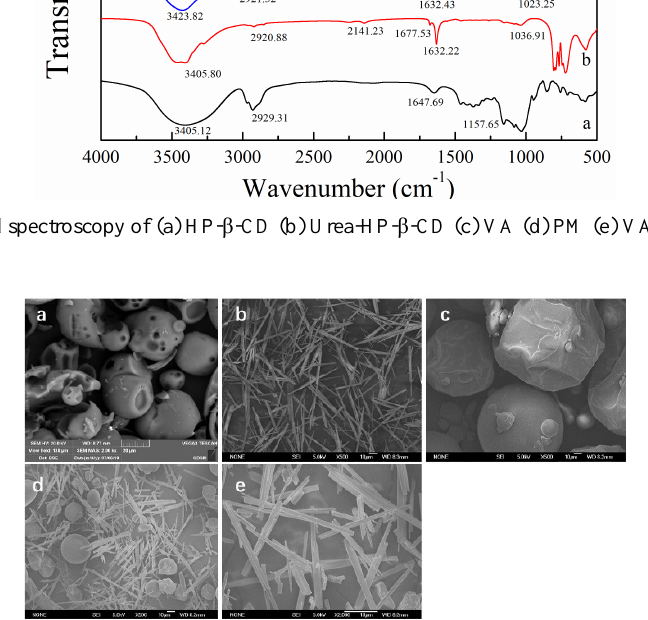
Fig. 4. The SEM images of (a)HP- β -CD (b) Urea-HP- β -CD (c) VA (d) PM (e) VA@ Urea-HP- β